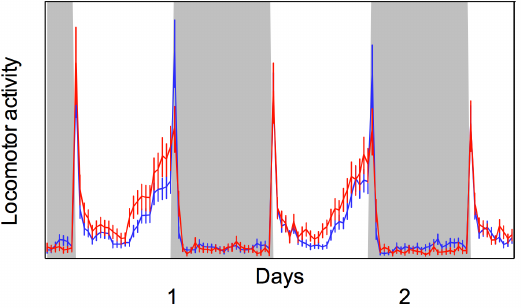
Figure 2. Linear regression curves of Aedesaegypti mortality after exposure to deltamethrin impregnated papers. Strains evaluated correspond to the susceptibility control (Rock), the 1016 Ile/ Ile selected strains with genetic background from a natural population (CIT-32) or from Rock (Rock-kdr), and the F1 offspring between Rock-kdr and Rock (Hib-F 1 ).